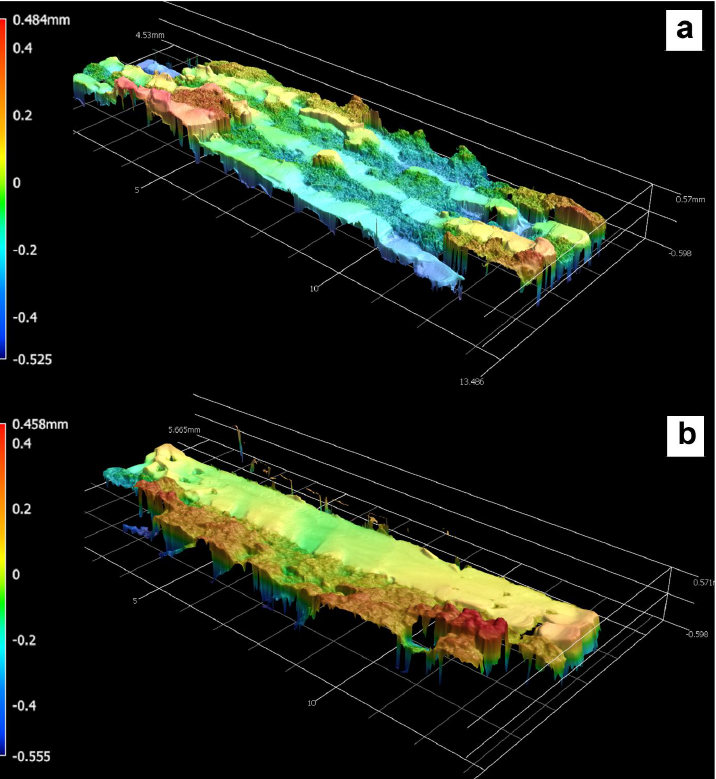
Figure 8. 3-D scans of fracture surfaces of multi-material ULTEM 9085 + ULTEM 9085 CF parts with layering patterns ABABAB ( a ) and AAABBB ( b ).